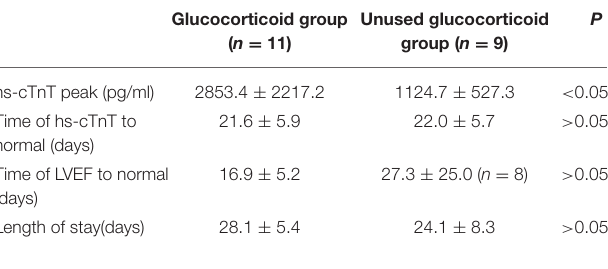
TABLE 2 | Comparison of the hs-cTnT peak and the length of stay between the glucocorticoid group and the unused glucocorticoid group. Glucocorticoid group Unused glucocorticoid ( n = 11) group ( n =